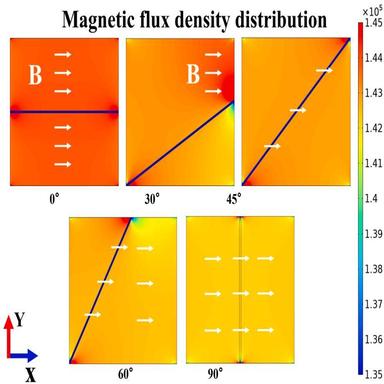
Magnetic flux density distribution of oblique boundaries with different angles.